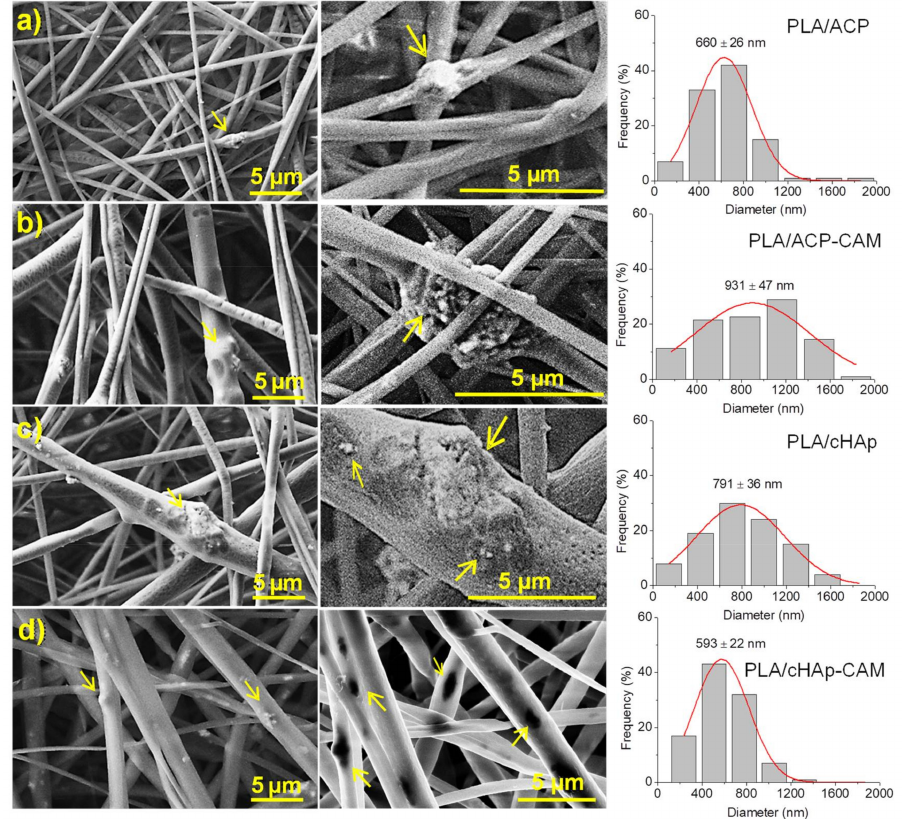
Figure 9. SEM images showing the morphology of PLA microfibers loaded with: ( a ) ACP, ( b ) ACP-CAM, ( c ) cHAp and ( d ) cHAp-CAM. Arrows point out the presence of nanoparticle agglomerates inside microfibers. In the middle column, higher magnification images are shown with aggregates of the nanoparticles inside the fibers. Image registered with the InLens detector ( d , middle) that evidences the presence of nanoparticles as black spots (in this case the di ff erent phases of PLA matrix and the cHAp particles can be di ff erentiated). The last column shows the distribution of the diameter of the fibers adjusted to a Gaussian model with the mean ± SE